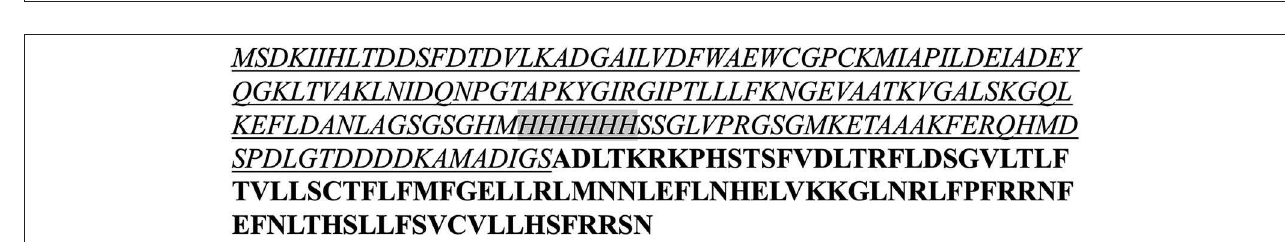
FIGURE 6 | Analysis of unmapped reads. (A) Count of BLAST hits to unmapped reads. (B) Counts of BLAST hits of unmapped reads to T. parva genome.